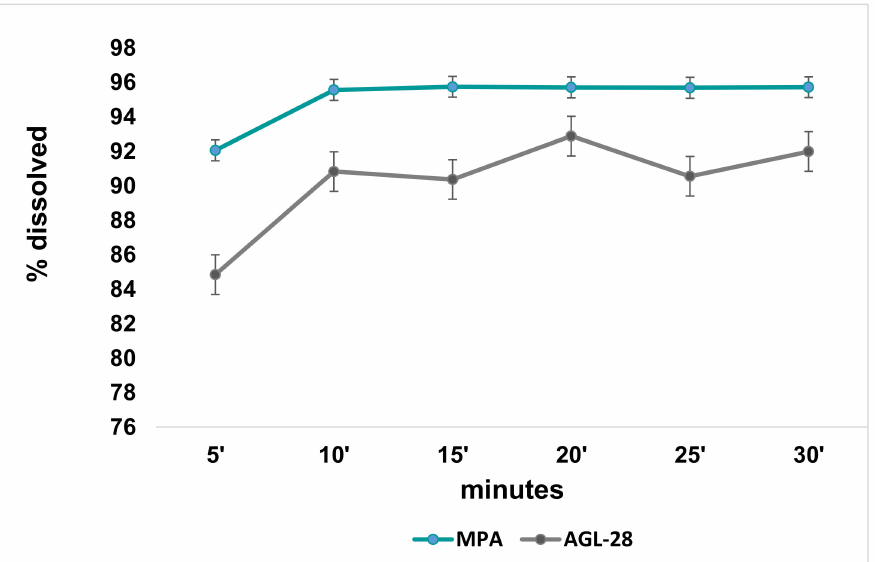
Figure 6. In-vitro dissolution profile in water of the raw extract (AGL-28 dark green line) and MPA powder (light green